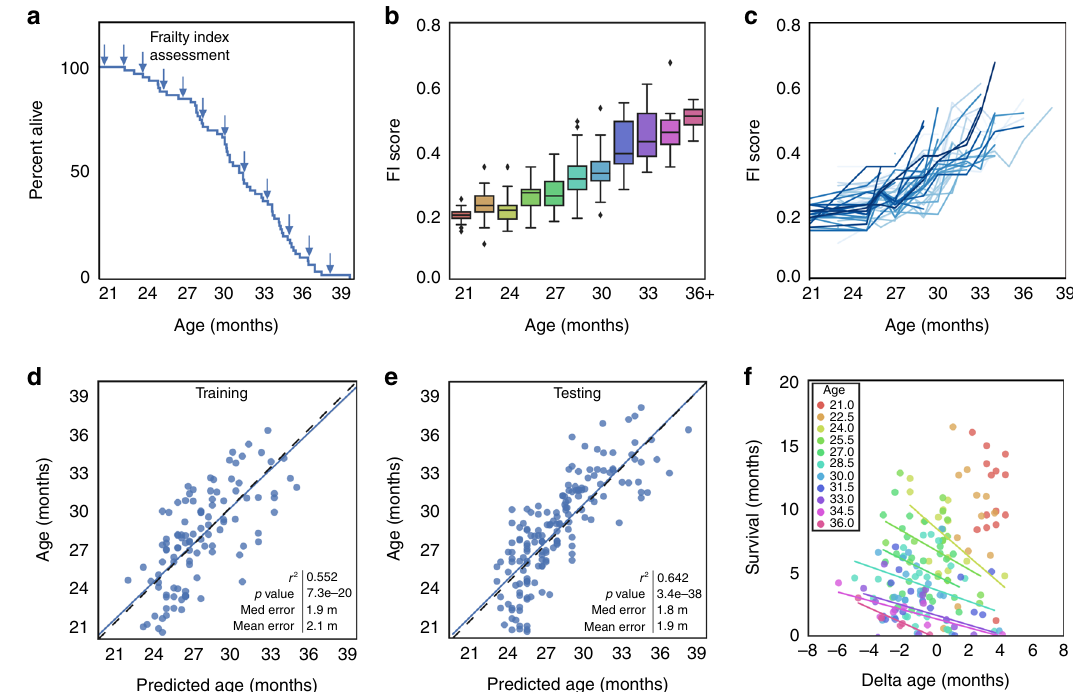
Fig. 1 Frailty correlates with and is predictive of age in mice. a Kaplan – Meier survival curve for male C57BL/6 mice ( n = 60) assessed longitudinally for Frailty Index (FI) (indicated by arrows). b Box and whisker plots displaying median FI scores for mice from 21 to 36 months of age. Colors indicate different ages ( n = 24, 27, 20, 29, 43, 36, 32, 25, 18, 11, 6). Box plots represent median, lower and upper quartiles, and 95 percentile. c FI score trajectories for each individual mouse from 21 months until death. d Univariate regression of FI score for chronological age on a training dataset, and e a testing dataset. For training and testing datasets, data were randomly divided 50:50, separated by mouse rather than by assessment, n = 106 datapoints for training and n = 165 for testing. Correlation determined by Pearson correlation coef fi cients. f Residuals of the regression (delta age), plotted against survival for individual ages (as demonstrated by different colors). Regression lines are only graphed for ages where there is an r 2 value >0.1. Source data are provided as a Source Data fi